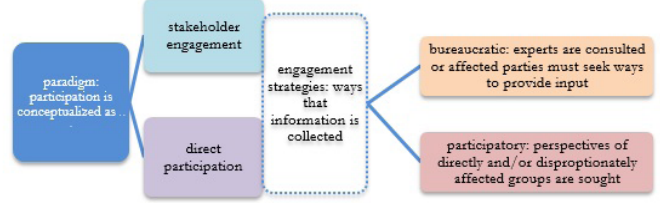
Figure 3: Conceptual framework